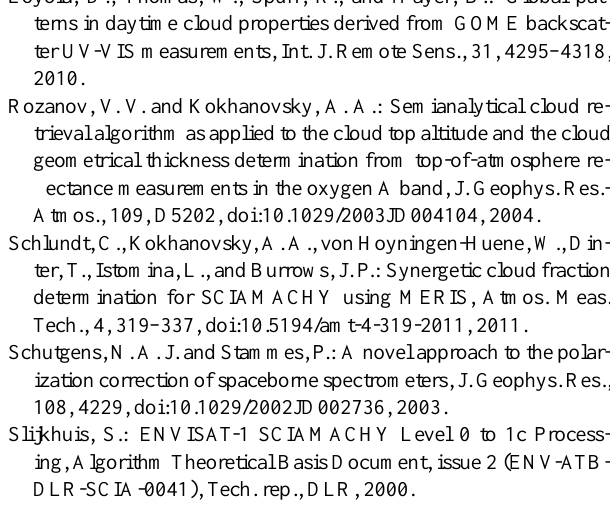
Wenig, M.: Satellite Measurements of Long-Term Global Tropo- spheric Trace Gas Distributions and Source Strengths, Ph.D. the- sis, University of Heidelberg, Germany,